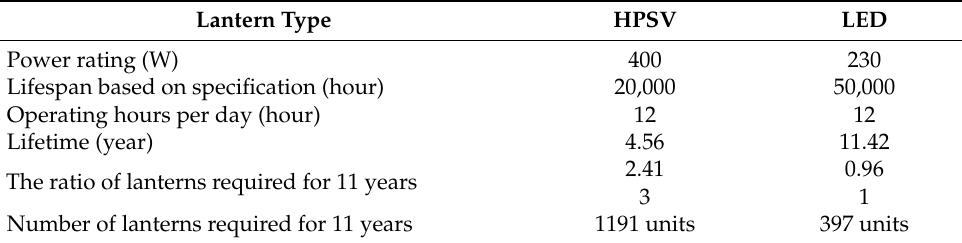
Table 4. Number of lanterns required for 11 years between HPSV and LED lanterns.